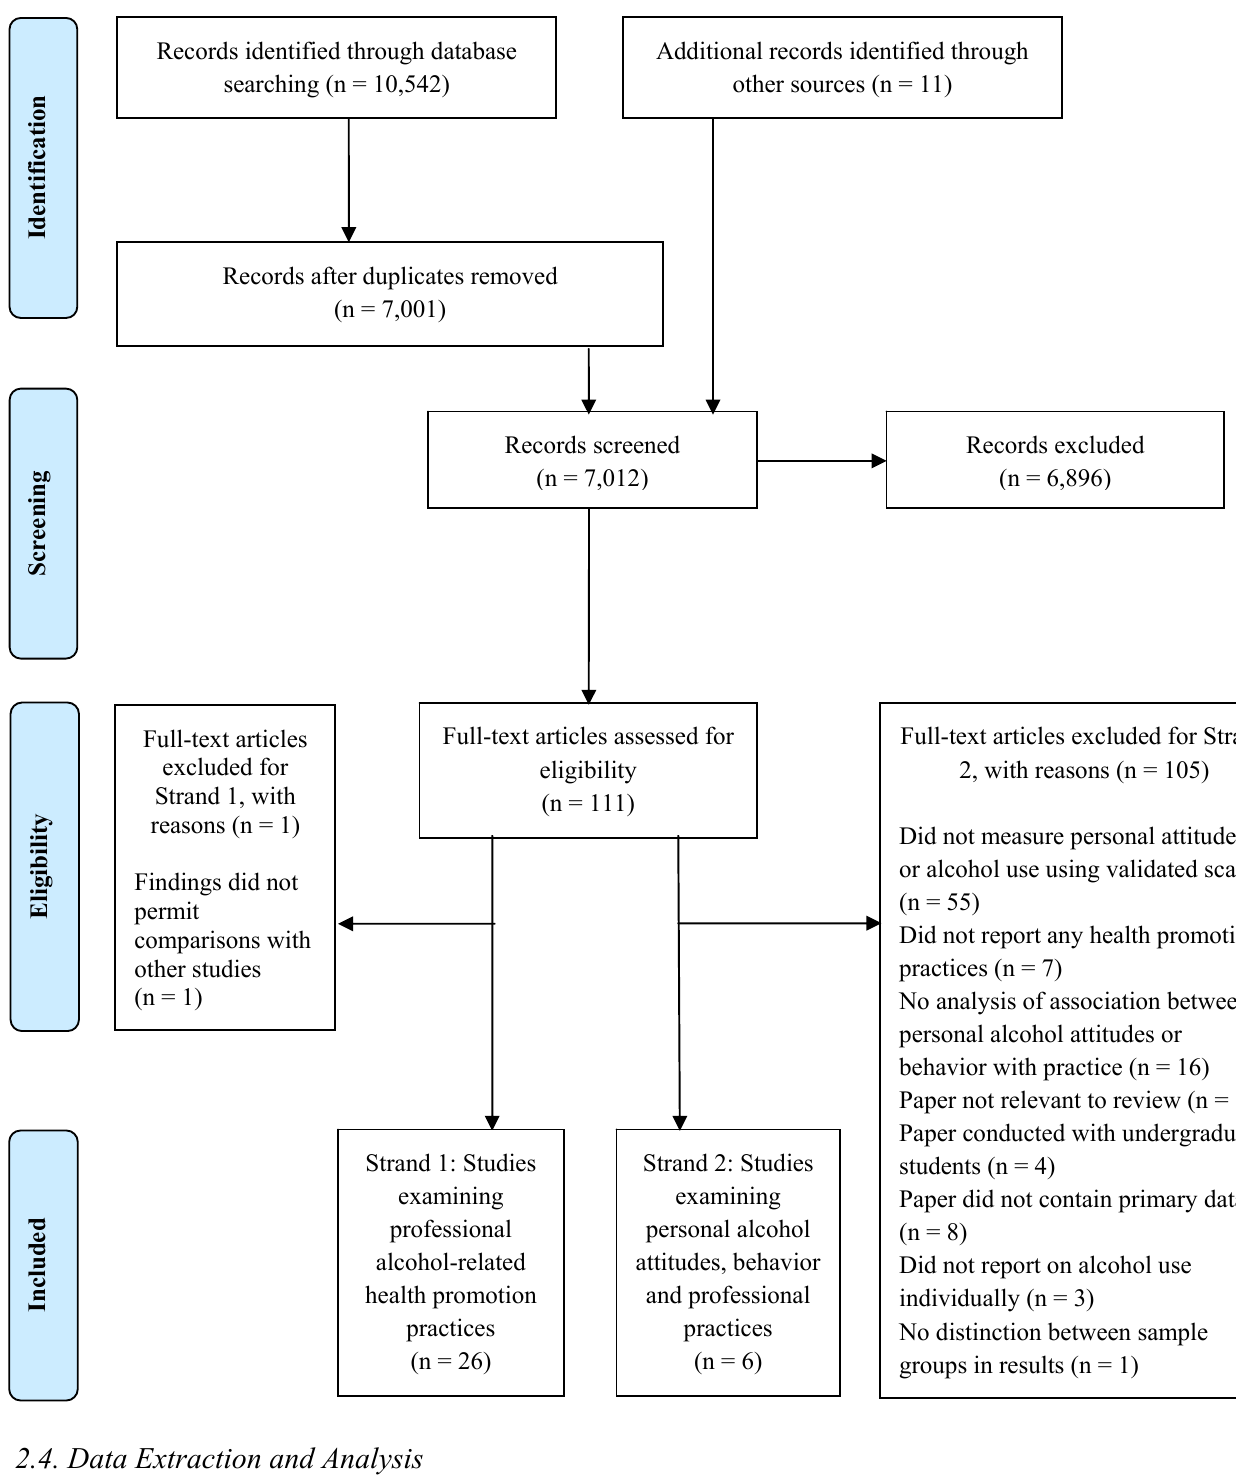
Figure 1. PRISMA flow